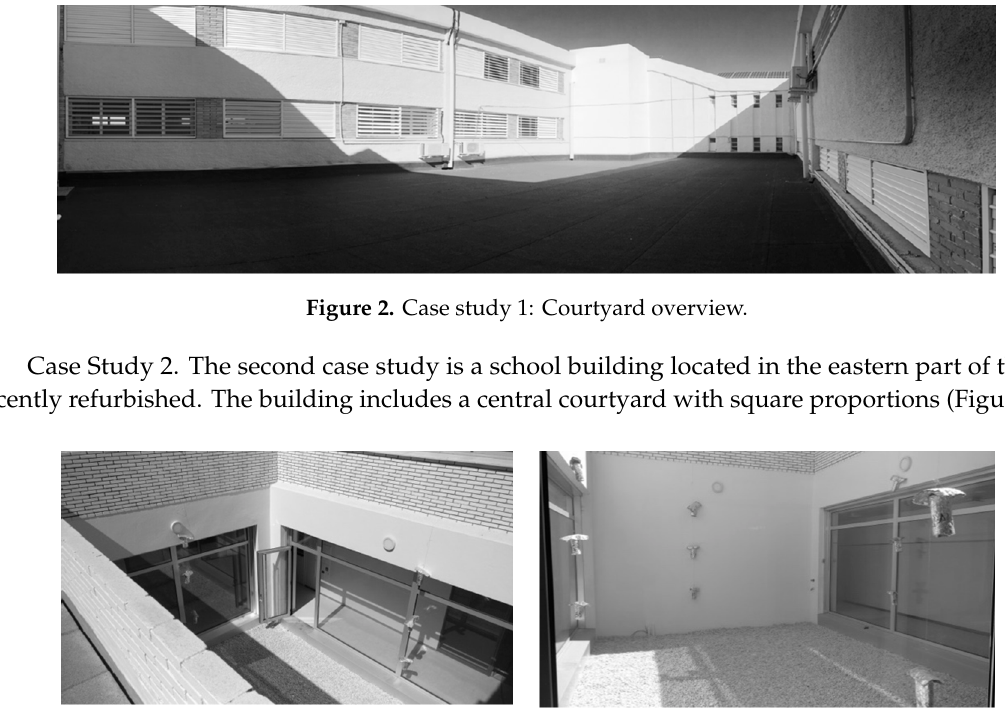
Figure 3. Case study 2: Courtyard overviews.